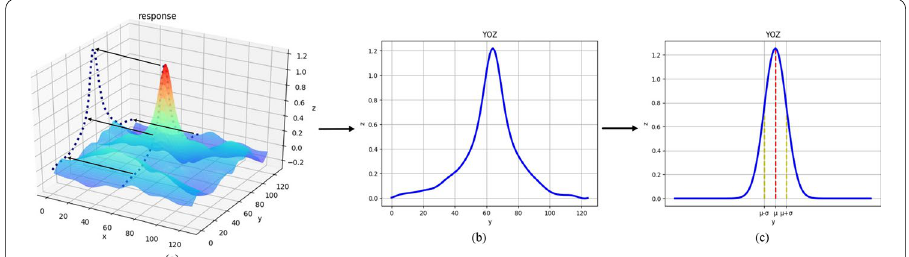
Fig. 5 Schematic diagram of the projection and fitting of the total response on the YOZ